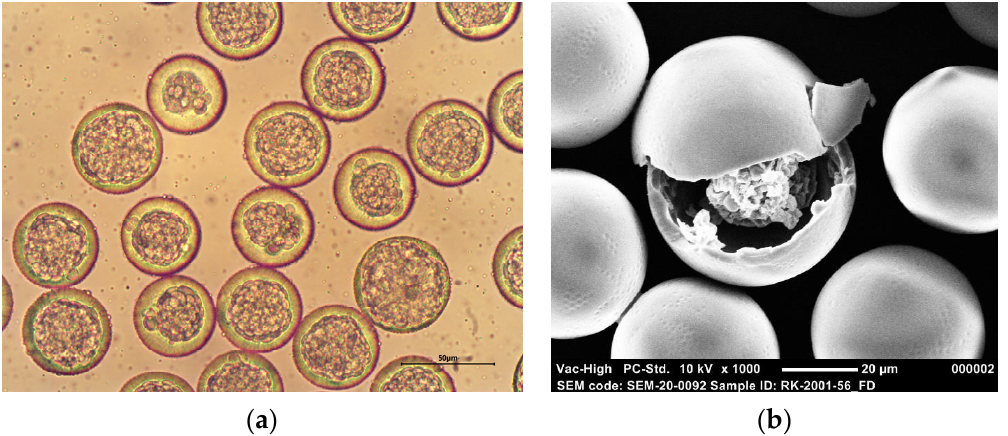
Figure 2. Representative images of BSA-loaded core–shell microspheres: ( a ) Optical microscopy image at 400× magnification; ( b ) Scanning electron microscopy (SEM) image at 1000× magnification. The shell of the microspheres was composed of PDLG7502, and the actual BSA loading was 5.7 wt % (Formulation F).